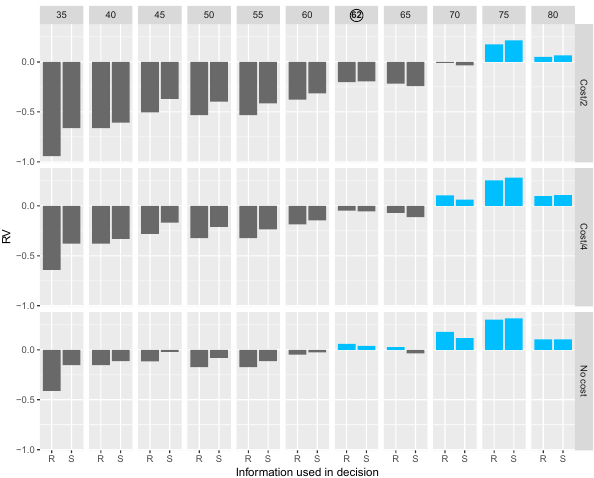
Figure 8. Relative value (RV) with different levels of cost for plant- ing for decisions informed by reservoir level alone (R) and with the addition of snow information (S) for the 10 sets of thresholds and the optimized thresholds (labelled as